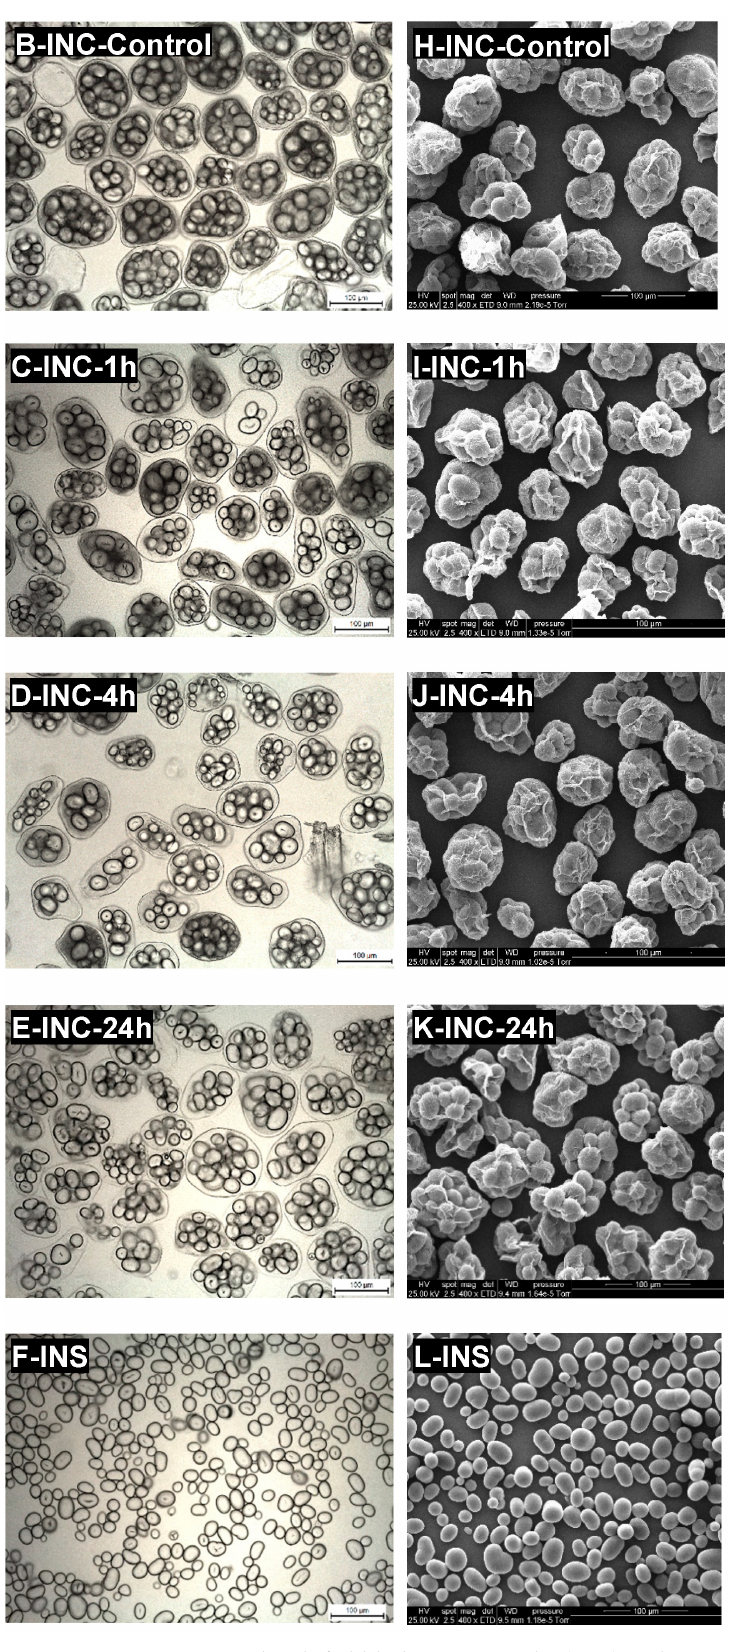
Figure 2. Representative brightfield light micrographs ( A – F ) and scanning electron micrographs ( G – L ) of isolated navy bean starch (INS), native INCs, control INCs, and INCs preincubated with pepsin for 1, 4, or 24 h at 37 ◦ C and pH 2.0. Scale bar = 100 µ